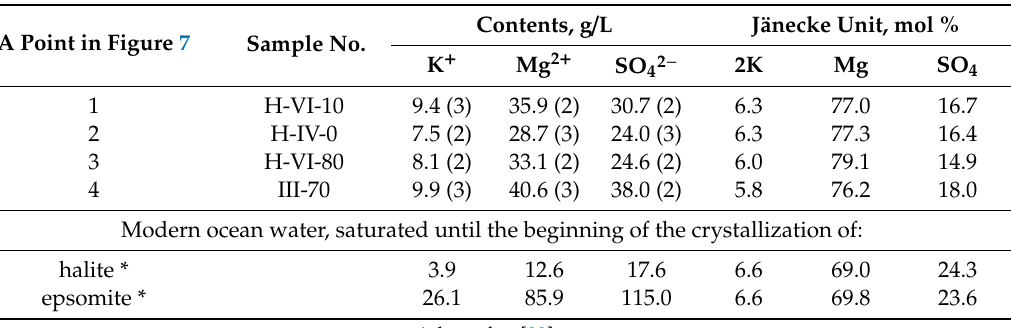
Table 2. Chemical compositions of brines collected from the primary fluid inclusions of halite. The numbers of fluid inclusions are given in parentheses.